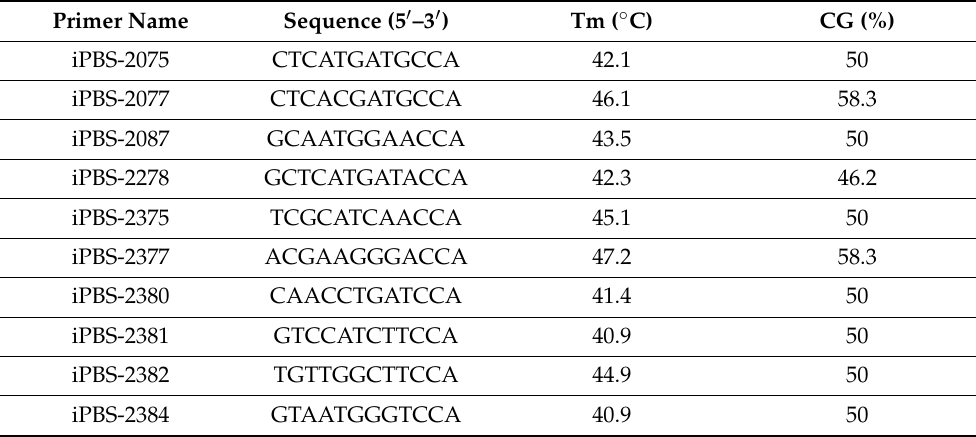
Table 3. Sequence information of 10 iPBS primers and their annealing (Ta)